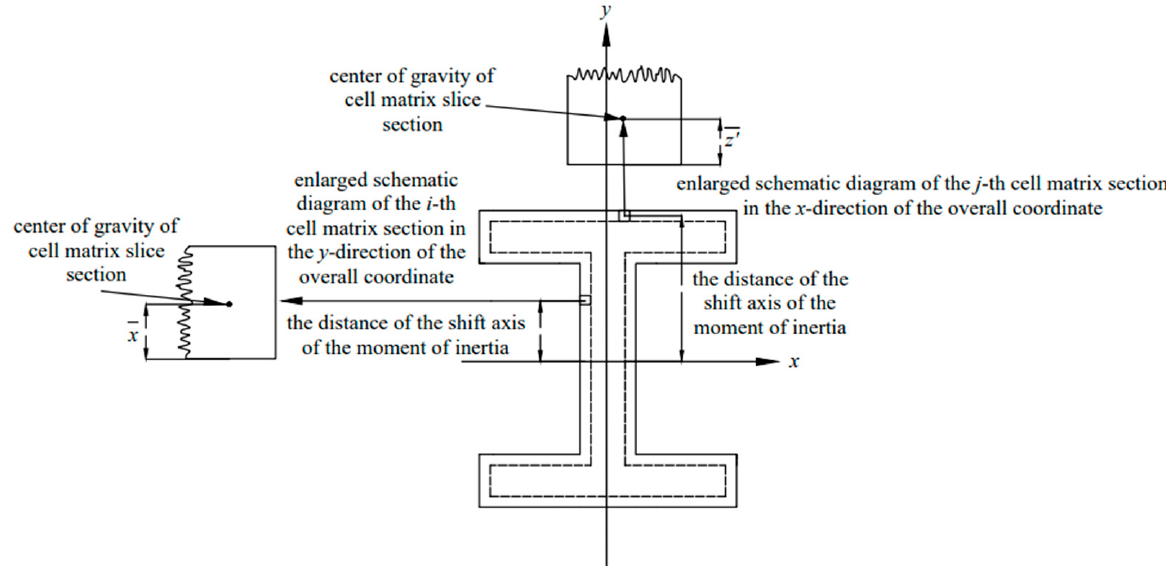
Figure 9. Schematic diagram of the axis-shifting process of the inertia moment of the H-beam cell matrix section.